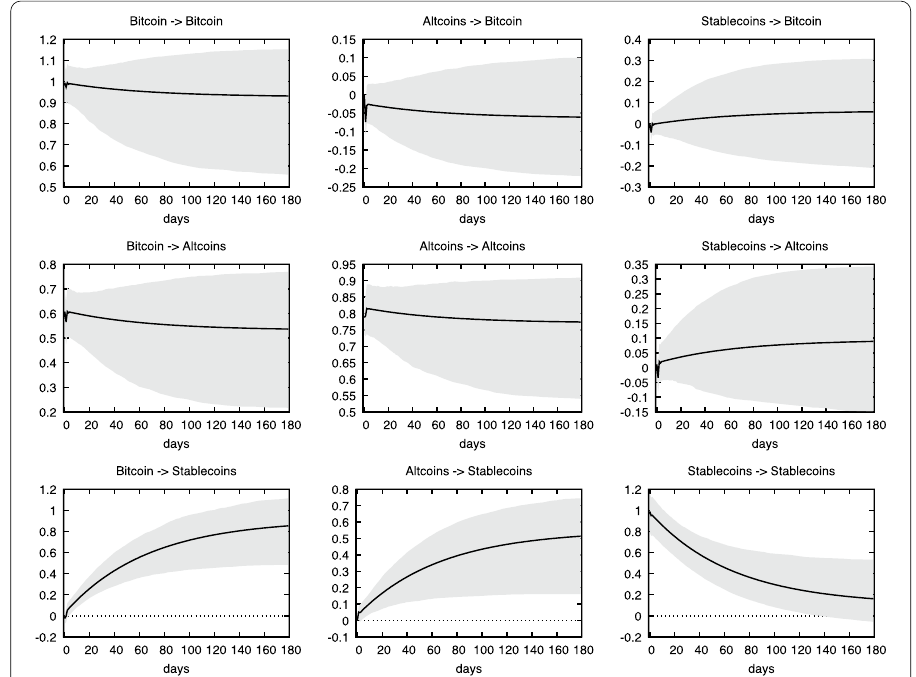
Fig. 2 Impulse-response functions of market capitalizations (long run). Impulse response functions based on the cointegrated VAR with 2 lags and an unrestricted trend are shown for the time horizon of 180 days ( x -axes) with a standard deviation of the given series as a unit of measurement. The effect of a unit standard deviation shock is shown on the y -axes. The black curves show the estimated effects, and the shaded areas represent the 90% bootstrapped confidence